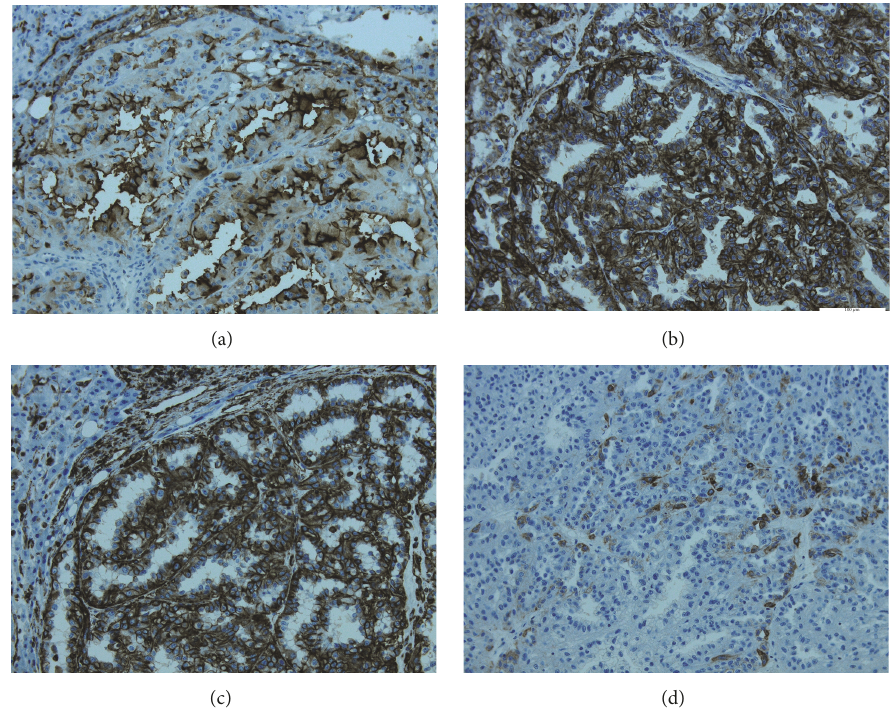
Figure 6: (a) CD10 positivity in the tumor cells. (b) CAM5.2 positivity in the tumor cells. (c) Vimentin positivity in the tumor cells. (d) CK7 being occasionally